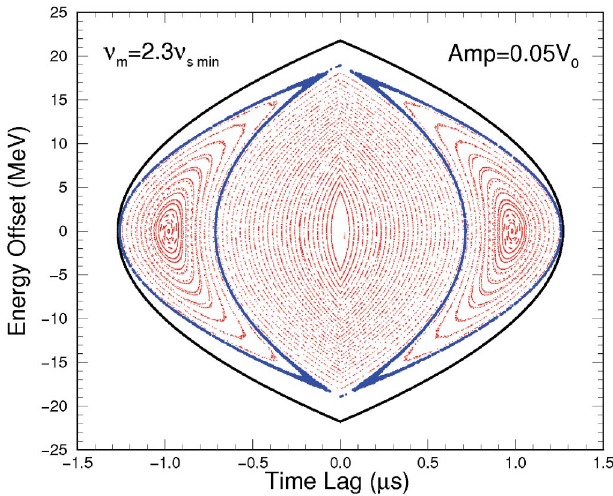
FIG. 4. (Color) Poincare´ section showing the excitation of the (cid:1) 2 : 3 (cid:4) and 2:1 resonance by rf voltage modulation at (cid:1) m s; min (cid:1) 0 : 05 V modulation amplitude aV . The separatrices shown 0 0 just touch the barrier bucket boundary, indicating that particles situation near the inner branches of the separatrices will be lost. The simulation involves initially 100 randomly but uniformly distributed particles and has been tracked for 5 (cid:3) 10 6 revolution turns (55.7